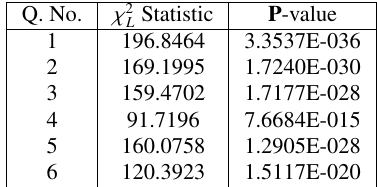
Table 5: Q -statistic and P -value for all the questions The methodology adopted for hypothetically ranking the schemes has been explained earlier in this paper. The column-wise rank sums are added up and the post-hoc analysis was conducted for each of the LibreO ffi ce Calc Sheets corresponding to each of the questions. The column wise rank sums R · j , j = 1 , ··· , 12 are laid out in the increasing order for each of these sheets and ranks are given from 1 to 12, according to the standard competition ranking scheme. The ties in this scenario are determined using equation (2). The values of the χ 2 statistic and the corresponding P val- L ues are presented in Table [6]. The ranks obtained are presented in Table [7]. Here, equal ranks have been replaced by average ranks.